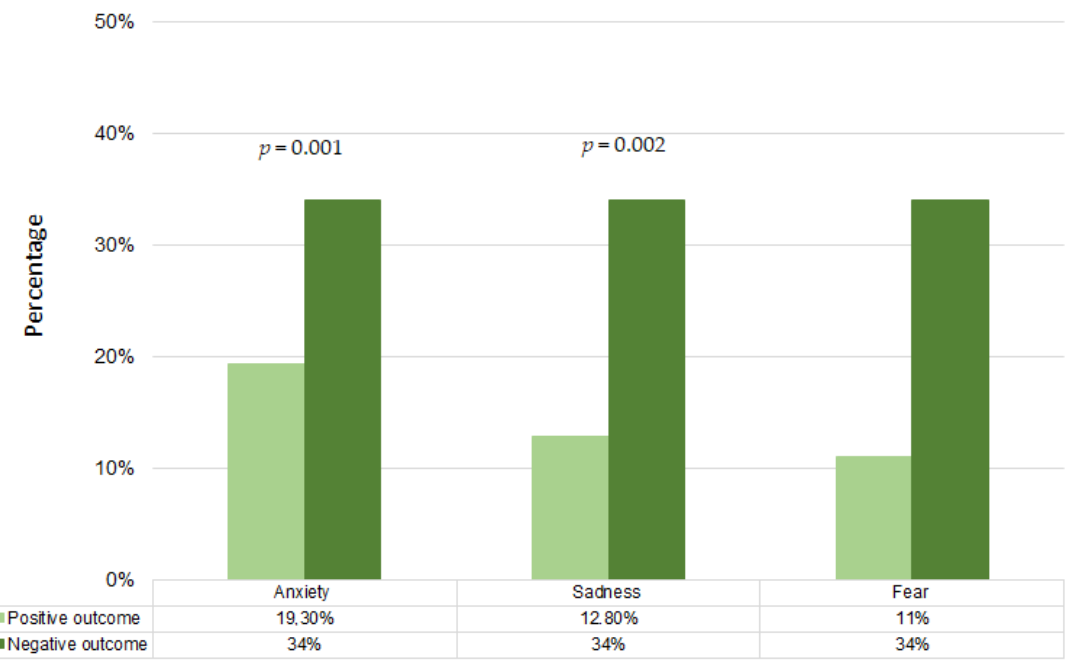
Figure 4. Distribution of women experienced anxiety, sadness, and fear, during COVID-19 pandemic according to ART outcomes (positive outcome vs. negative outcome).